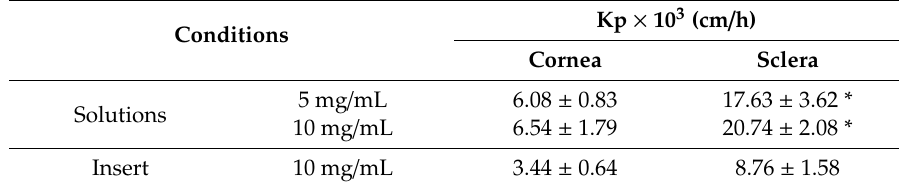
Table 3. Permeability coe ffi cient of GSH through cornea and sclera (Kp × 10 3 , cm / h) using di ff erent formulations (Mean ± SD; n ≥ 3) * p <